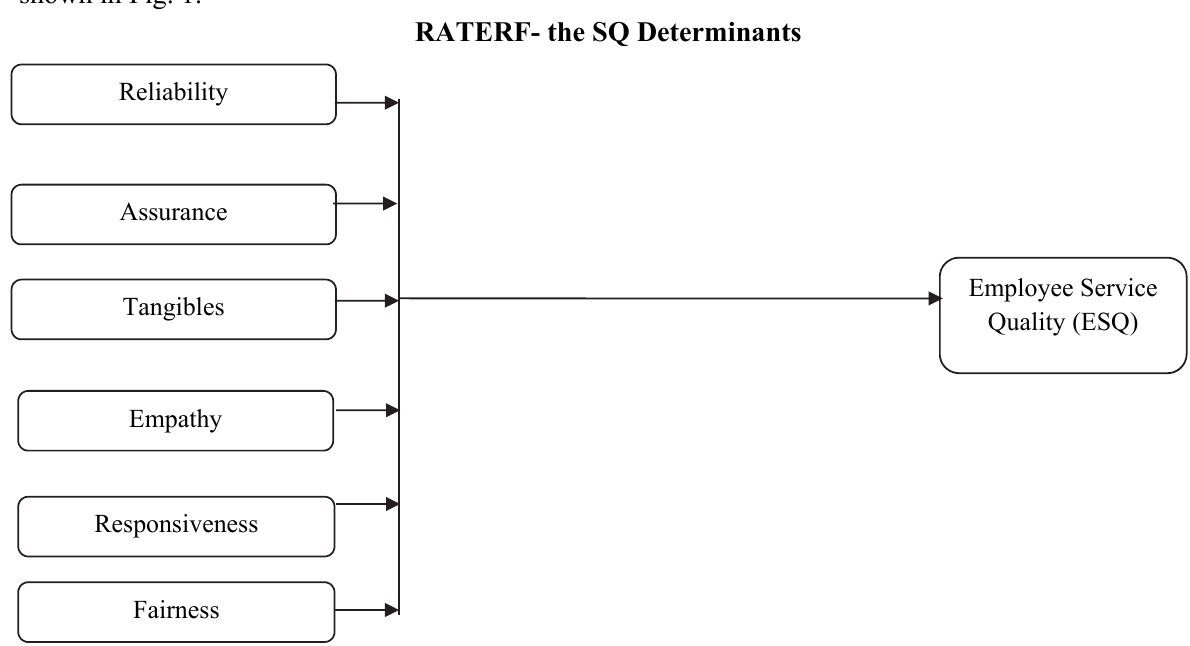
Fig. 1. Relationship between Independent Variables and Dependent Variable In this study, employee service quality was treated as dependent variable with hybrid model RATERF comprises of six independent or antecedent